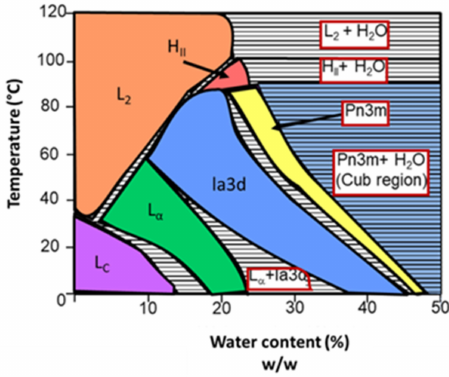
Figure 7. Aqueous phase behavior of the monoolein–water system. L c and L ∝ represent the lamellar phases (crystalline and fluid, respectively). Ia3d and Pn3m are the inverted bicontinuous cubic phases. L 2 and H II correspond to the inverted micellar and hexagonal phase, respectively. Adapted from Kulkarni et al., 2011